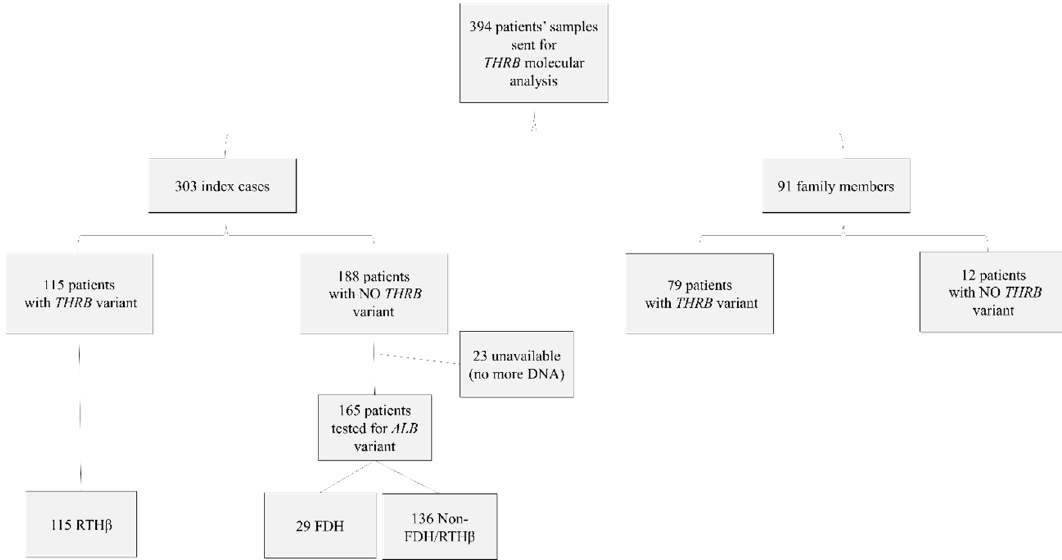
Figure 1. Molecular analysis performed on samples received for suspected impaired sensitivity to TH or family studies in the Reference center for rare thyroid disease of Angers University Hospital, France, between 2000 and 2015. Family members: family members related to index cases; unavailable (no DNA for ALB molecular analysis).